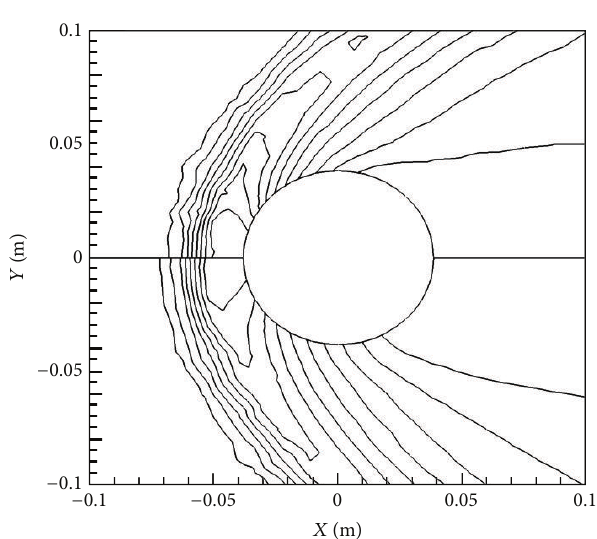
Figure 12: Comparison of density contours without magnetic field (top) and with 𝐵 max = 2 T oriented in 𝑌 -direction